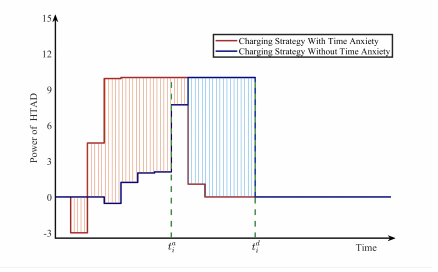
Figure 12. The time anxiety impact of